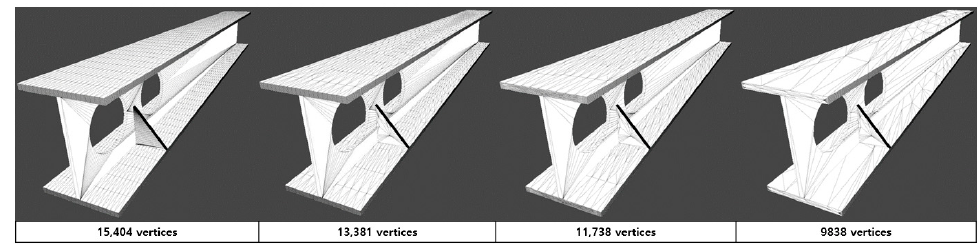
Figure 2. Sample of mesh optimization